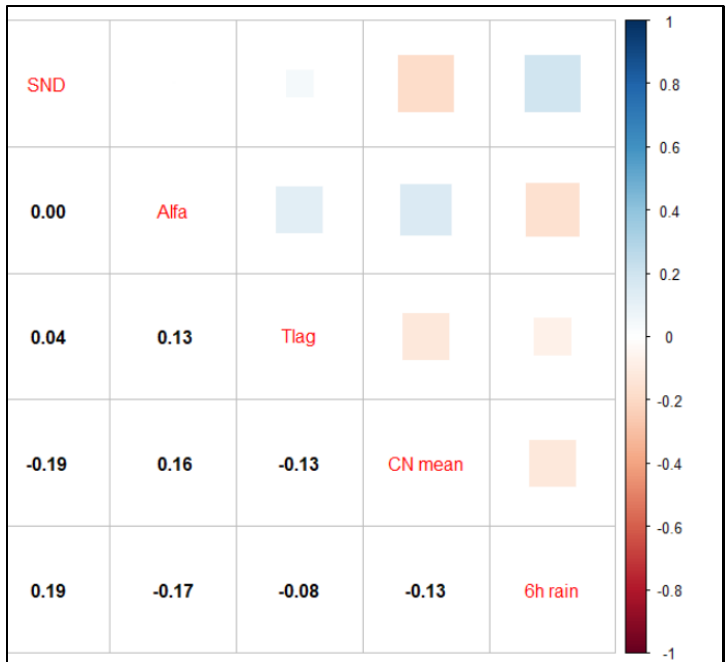
Figure 5. Correlation of five selected parameters. The correlation coefficients are numerically shown below the diagonal, and the correlations are visually presented above the diagonal, as in Figure 2. The selected parameters can be regarded as independent variables.